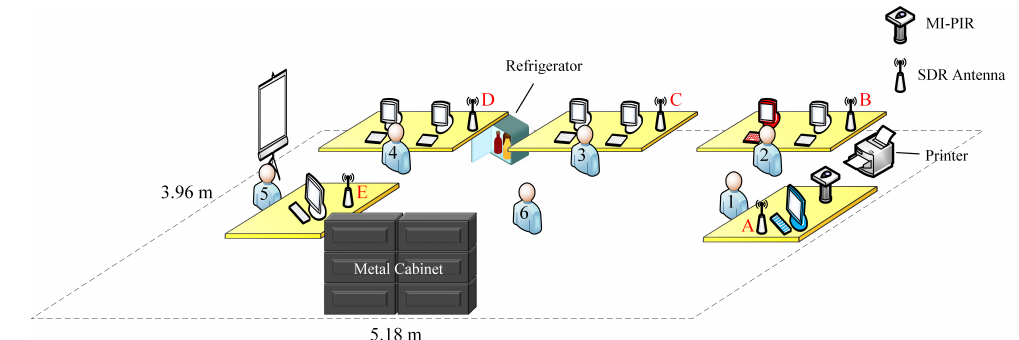
Figure 4. Illustration of the academic office space used to collect the data. The red and blue computers are used as the host computers for the SDR devices and the MI-PIR system, respectively. The white computers are not used.